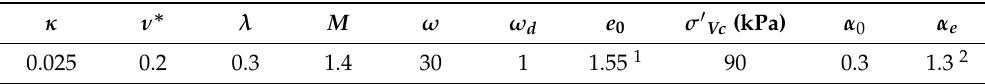
Table 1. Model parameters for Bothkennar clay.